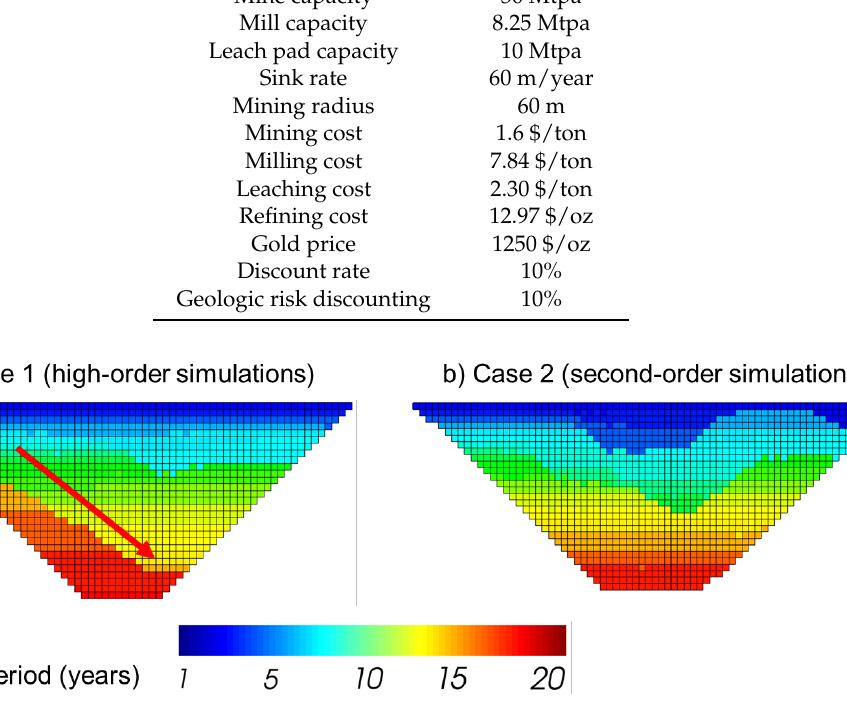
Figure 6. Cross-section of the life-of-mine (LOM) production schedule (plane East–West) obtained in ( a ) Case 1 and ( b ) Case 2. The red arrow shows the preferential mining direction along the direction of higher continuity of high-grades.